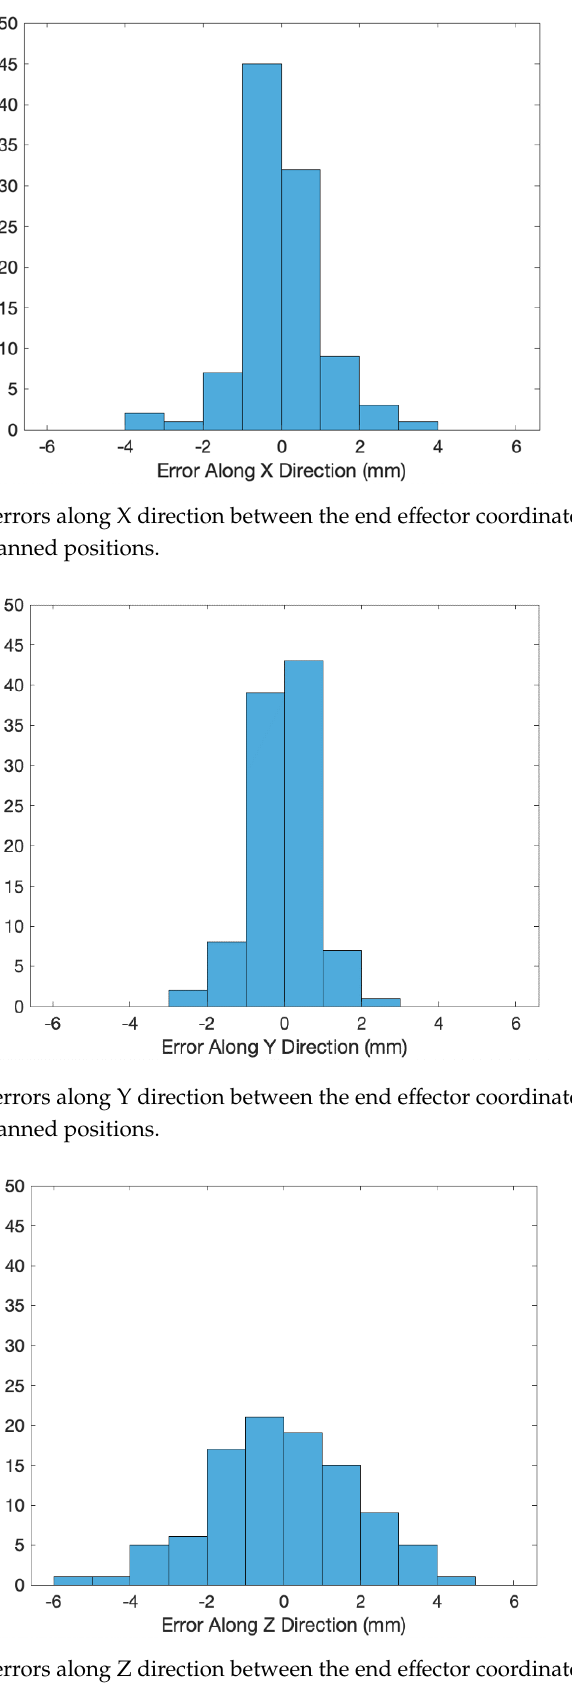
Figure 5. Histogram of errors along Z direction between the end effector coordinates and transformed coordinates of the 3D scanned positions.